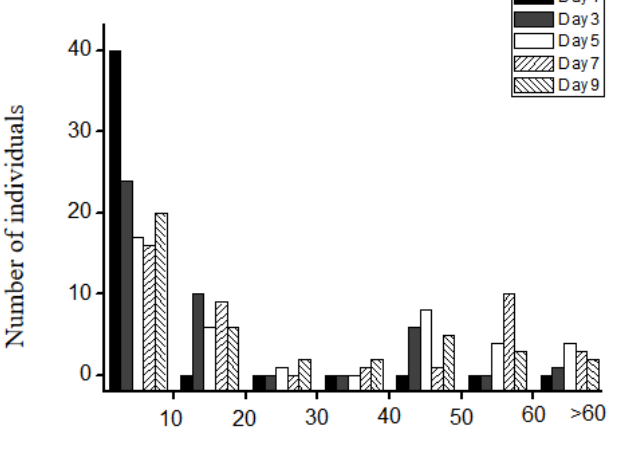
Figure 2. Distribution of the maximum of single flight among individuals on different days after emergence.